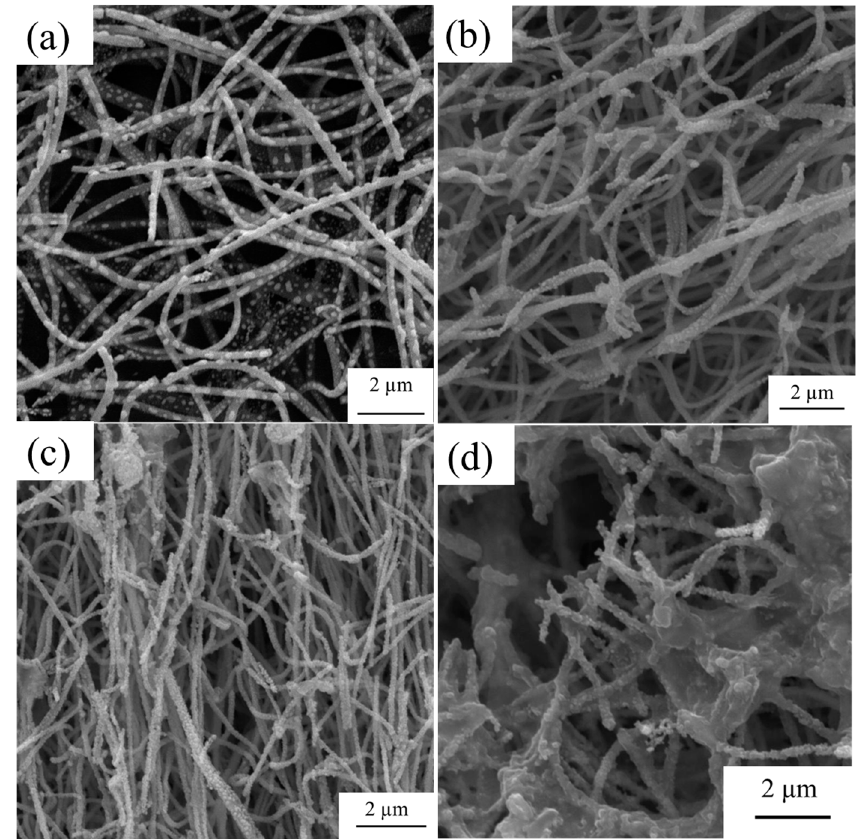
Figure 1. SEM micrographs of ( a ) Au-decorated ZnO nanofibers and Au-decorated ZnO-PANI composite nanofibers with different amounts of PANI; ( b ) 10; ( c ) 25; ( d ) 50 wt.%.